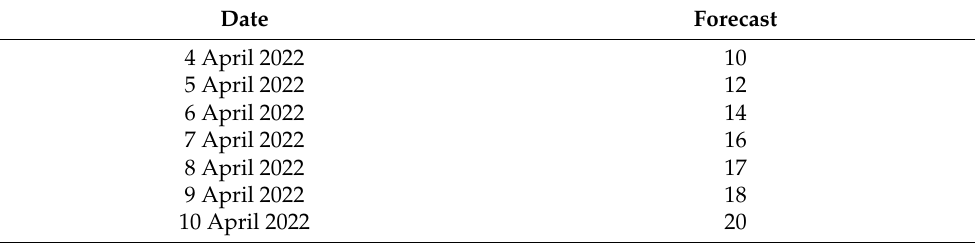
Table 3. Forecasting daily death cases caused by COVID-19 using LSTM.